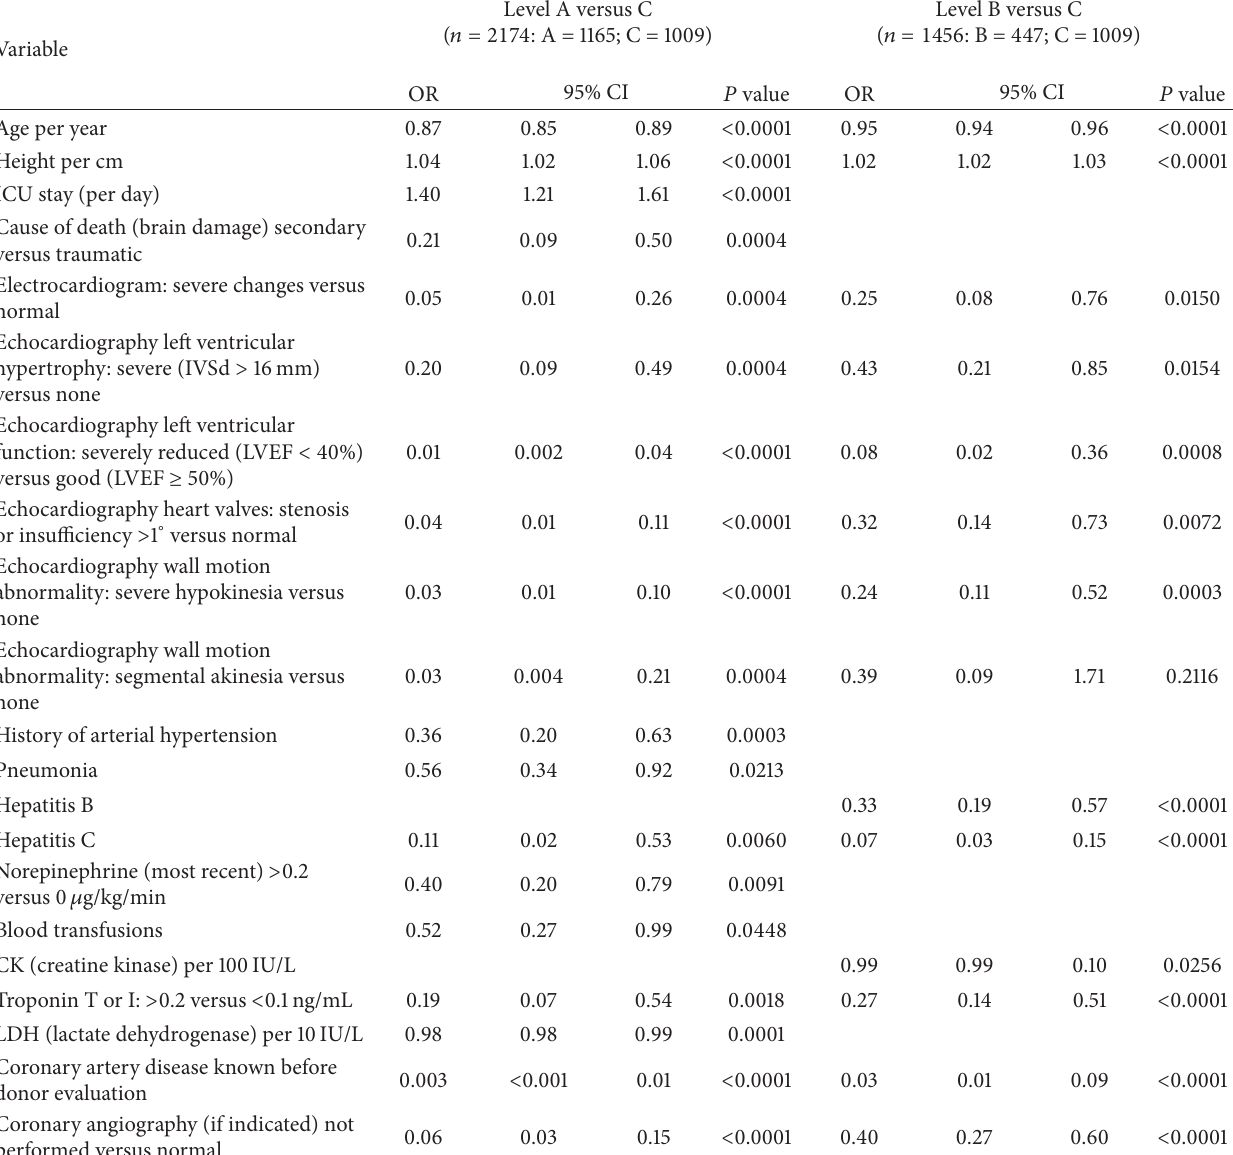
Table 2: Multivariate logistic regression models comparing Level A versus C and Level B versus C.